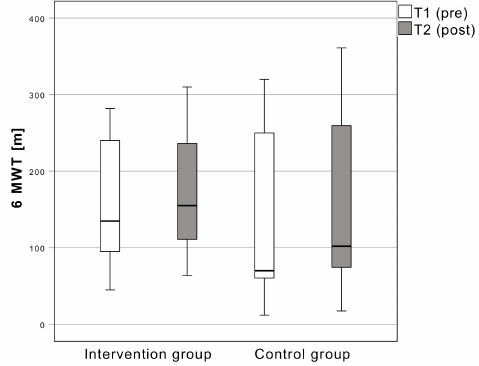
Figure 4. Results of the distance walked in the 6 min walking test. Boxplots: Middle line: median; lower whisker: minimum value; upper whisker: maximum value; circles: Outliers (1.5 times in- terquartile range); p < 0.05; T1: measurement pre-intervention; T2: measurement post-intervention; Confidence interval: 95%; n =